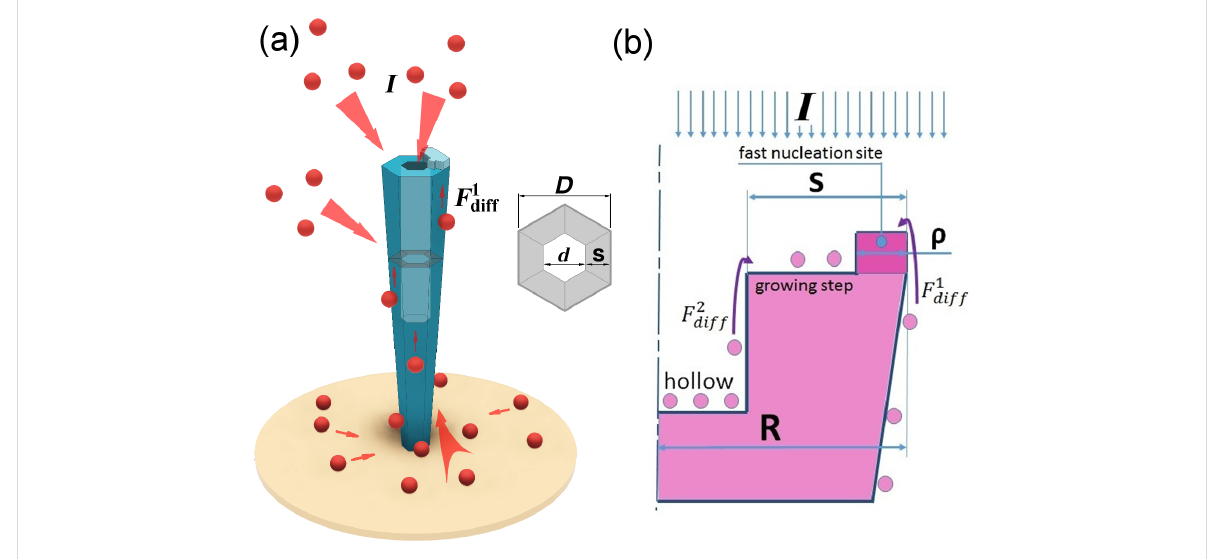
Figure 4: a) Nanotube growth schematics and b) model nanotube